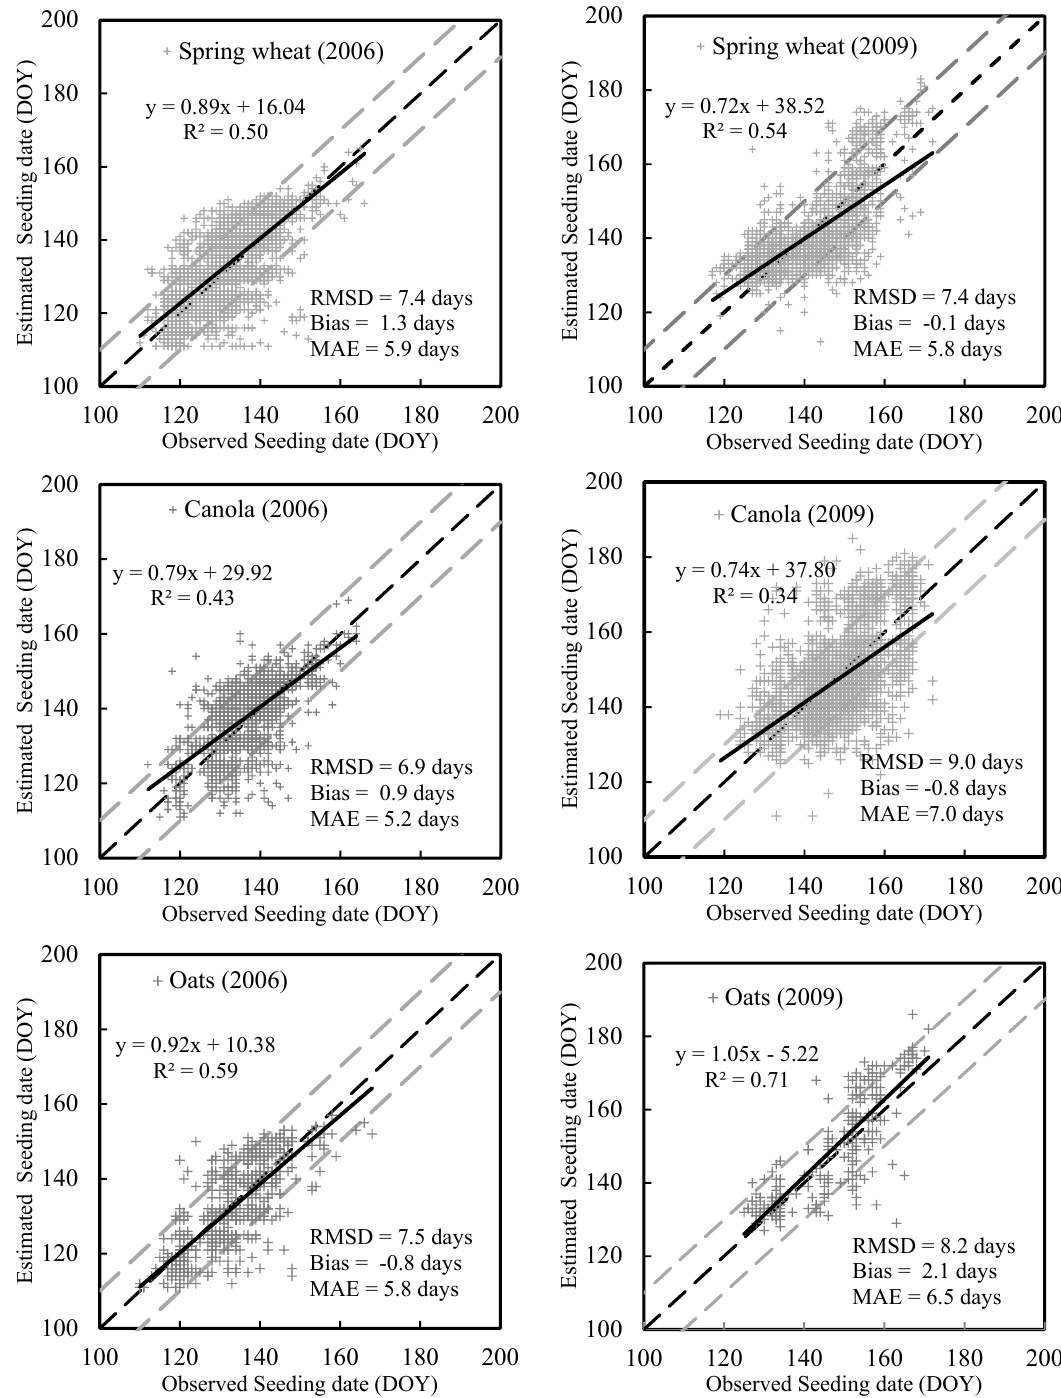
Figure 8. Comparison between observed and estimated seeding date using the threshold based approach (SOS 20 ); the dashed gray lines mark the 10-day confidence interval, and the dashed black line denotes the 1:1 line.